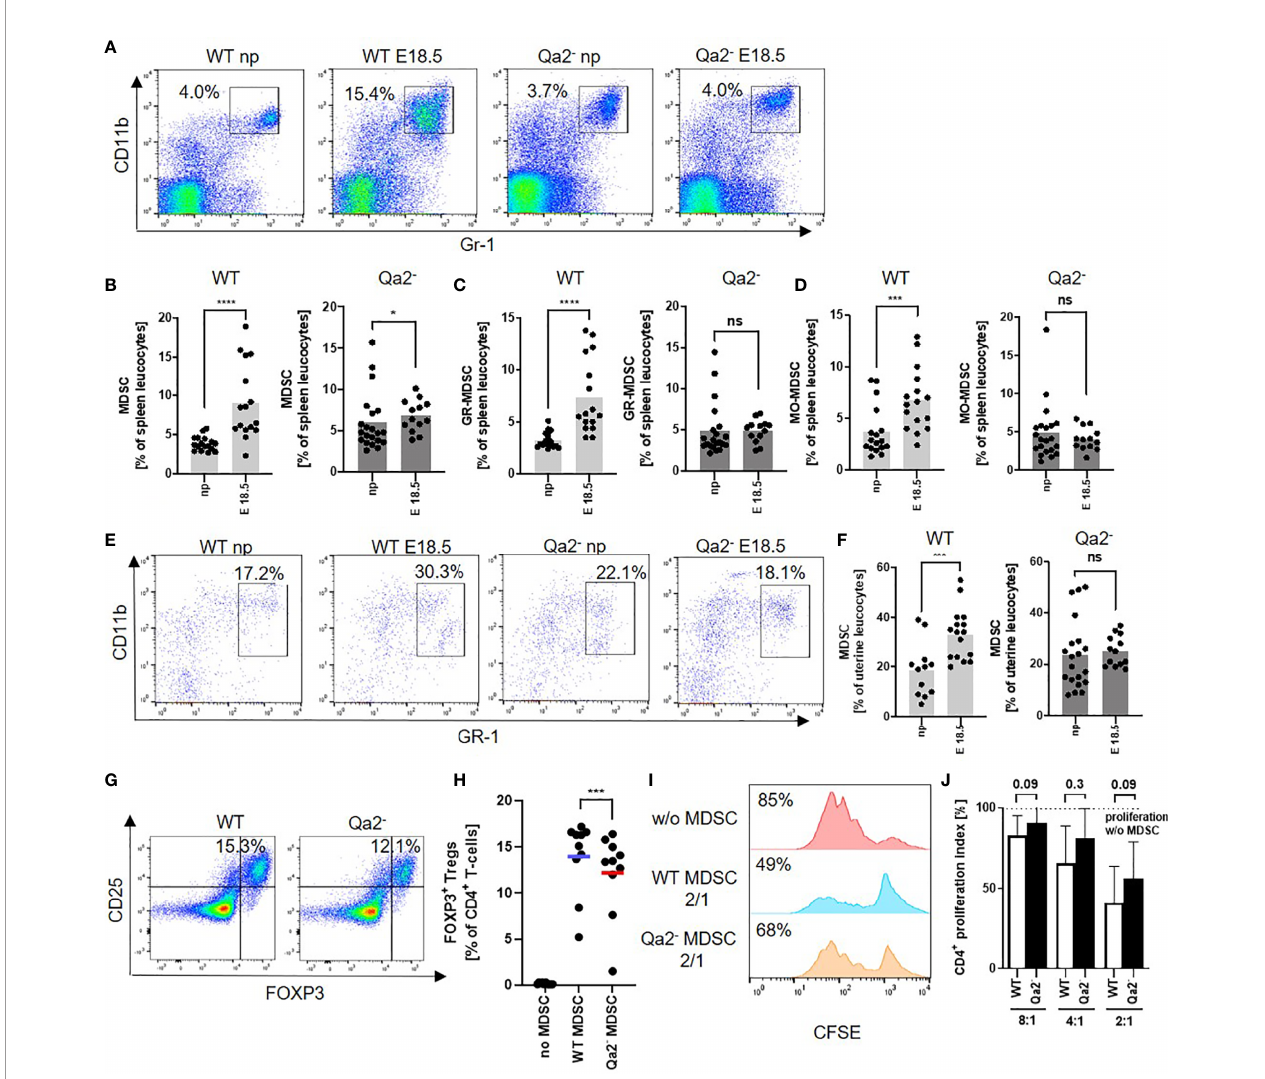
FIGURE 3 | Decreased accumulation and function of MDSC in Qa-2 de fi cient mice. Wildtype (WT) and Qa-2 de fi cient mice (Qa2 - ) were term-bred and the day when a vaginal plug was detected was de fi ned as day E0.5. Mice were euthanized at E18.5 and spleens and uteri were collected. Non-pregnant animals served as controls. Tissues were homogenized and fi ltered to obtain single cell suspensions and cells were analyzed by fl ow cytometry. (A) Representative pseudocolor plots for Gr-1 versus CD11b showing the population of MDSC in spleen leucocytes in the upper right quadrant. Cells were pre-gated on CD45. (B – D) Percentages of all MDSC (B) , GR-MDSC (C) and MO-MDSC (D) from all spleen leucocytes in non-pregnant animals (np, n=17 for WT and n=21 for Qa-2 - ) and pregnant animals at E18.5 (n=16 for WT and n=13 for Qa-2 - ). Light grey graphs represent WT animals and dark grey graphs represent Qa-2 - animals. (E) Representative pseudocolor plots for Gr-1 versus CD11b showing the population of MDSC in uterus leucocytes in the upper right quadrant. Cells were pre-gated on CD45. (F) Percentages of MDSC from all uterus leucocytes in non-pregnant animals (np, n=12 for WT and n=20 for Qa-2-) and pregnant animals at E18.5 (n=16 for WT and n=13 for Qa-2 - ). Light grey graph represents WT animals and dark grey graph represents Qa-2 - animals. Each symbol represents an individual animal and the mean is indicated. ****p < 0.0001; ***p < 0.001; *p < 0.05; ns, not signi fi cant. Mann-Whitney test. MDSC were in vitro generated from bone marrow cells (G+H) or isolated by magnetic activated cell sorting from E18.5 pregnant WT and Qa-2 - mice (I+J) and added to MACS isolated splenic CD4+ T-cells from WT mice. (G) Representative pseudocolor plots for Foxp3 versus CD25 showing the population of Foxp3+ T reg cells after four days of co-culture with MDSC generated from WT and Qa-2 - mice in a 2:1 (T-cells: MDSC) ratio in the upper right quadrant. Cells were pre-gated on CD45, CD3 and CD4. (H) Percentages of Foxp3 + T reg cells of all CD4 + T-cells without addition of MDSC, with addition of MDSC generated from WT mice and with addition of MDSC generated from Qa-2 - mice (n=10). Each symbol represents an individual animal and the mean is indicated. Bars represent pooled data from 6-7 independent experiments. (I) Representative histogram plots showing proliferation of CFSE-stained and anti- CD3/CD28 stimulated T-cells without addition of MDSC and with addition of MDSC generated from WT and Qa-2 - mice in a 2:1 (T-cells: MDSC) ratio. (J) Inhibitory effect of MDSC from WT mice (white bars) and Qa-2 - mice (black bars) on proliferation of CD4 + T-cells in different ratios (T-cells:MDSC) (n=6-7). Dashed line shows proliferation of target CD4+ T-cells without addition of MDSC. Proliferation index was determined as ratio of T-cell proliferation with and without addition of MDSC. **p < 0.001; ns, not signi fi cant. Wilcoxon matched pairs signed rank test (H) and Mann-Whitney test (J)